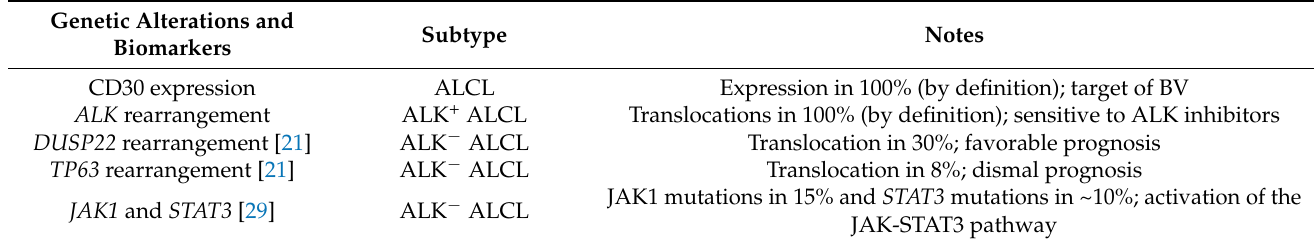
Table 2. Recurrent genetic alterations and key biomarkers of